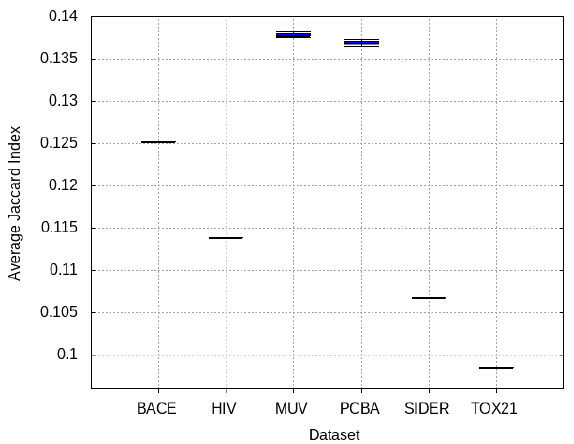
Figure 6. Similarity between each source dataset and the target dataset. Higher Jaccard Index indicates higher degree of similarity between the molecules.